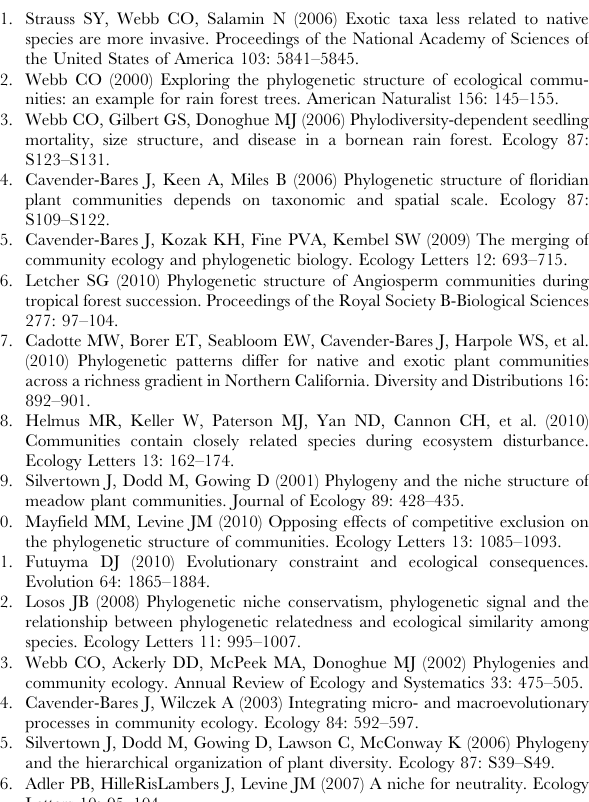
Figure S1 Results of maximum likelihood phylogenetic analysis on gene sequences for species used in the experimental plots, plus two outgroup species ( Amborella trichopoda and Magnolia grandiflora ). On the right is the full tree showing branch lengths from the phylogenetic analysis and on the left is a rate-smoothed ultrametric tree showing nodal support. Figure S2 The relationship between planted PD and the amount PD changed in plots (black dots and black dashed line) is within the possible values from 1000 random samples for each plot (grey circles and